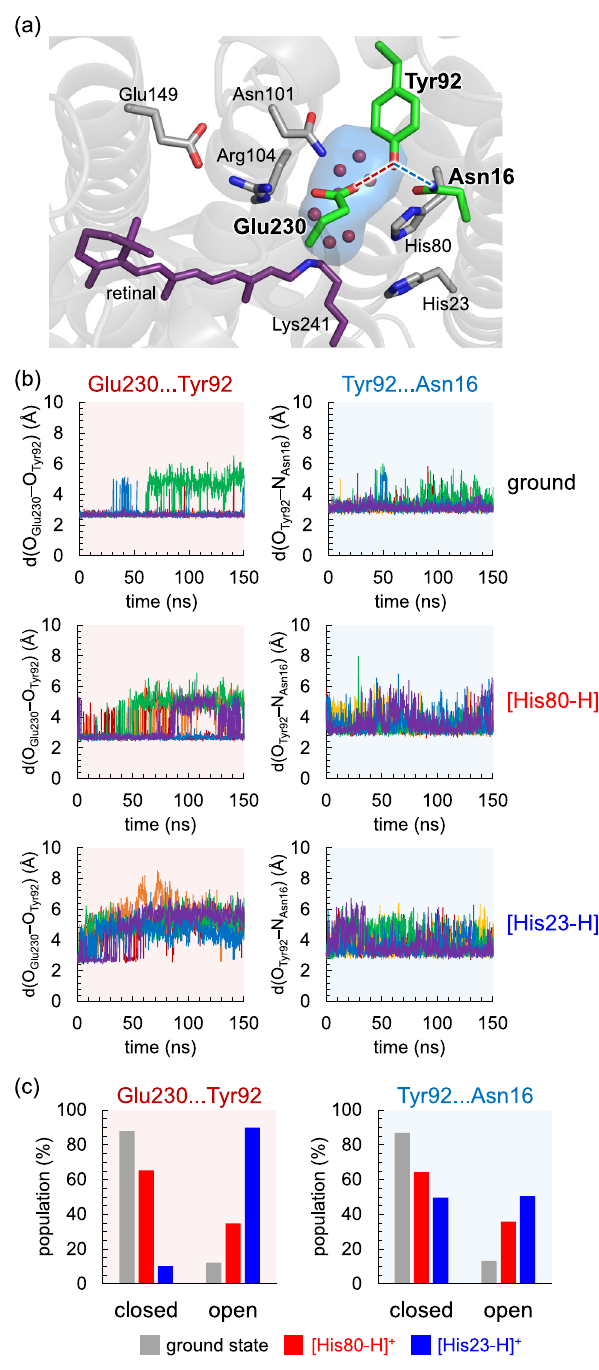
Fig. 8 Structural changes in the intracellular region in response